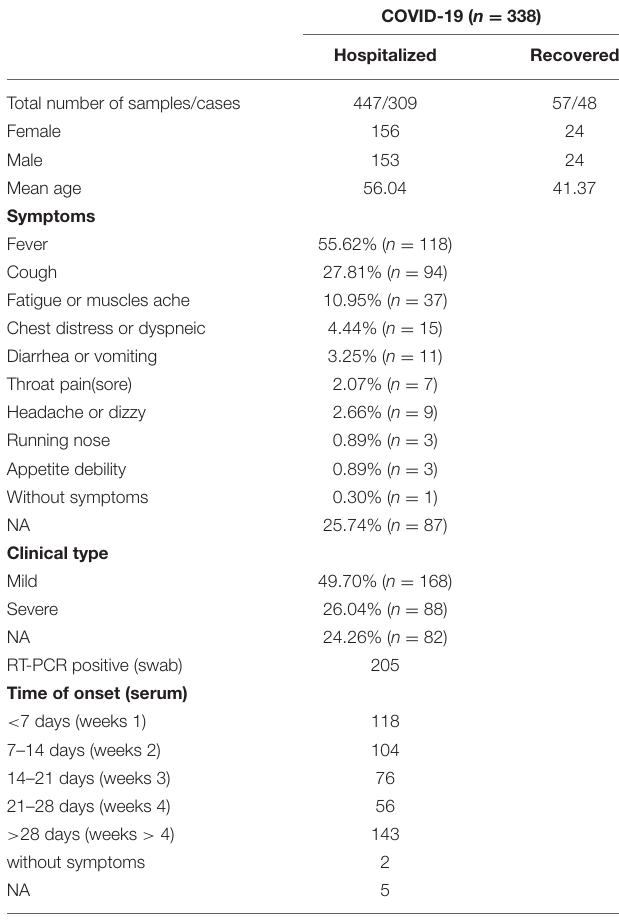
TABLE 1 | Demographics, baseline characteristics of 338